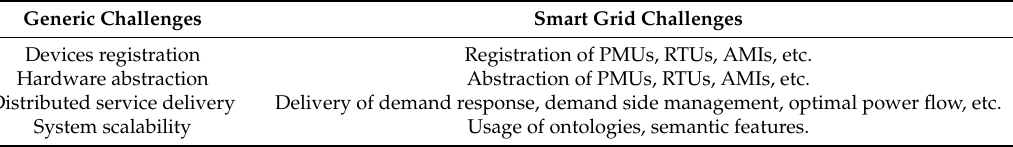
Table 1. Specific challenges for middleware in the smart grid.